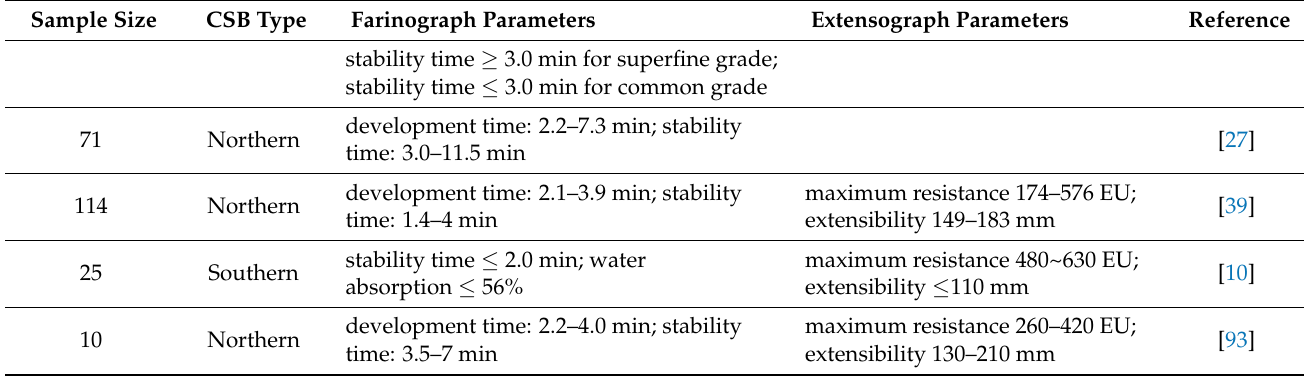
Table 2. Recommended Farinograph and Extensograph parameters for CSB